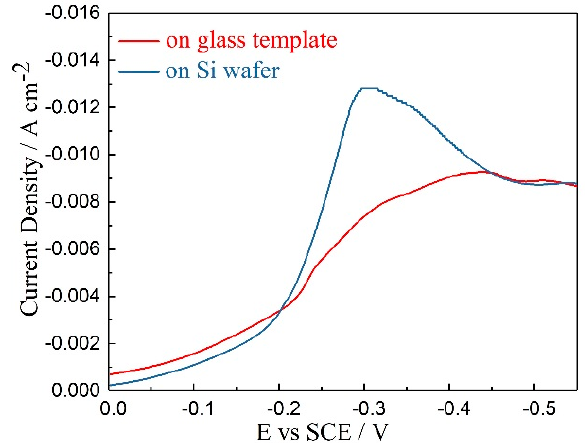
Figure 6. Cyclic voltammograms of Sb-Te electrodeposition on the Si wafer-based Pt electrode and glass template at room temperature at a scan rate of 5 mV/s with an electrolyte containing 8 mM of SbO + and 12 mM of HTeO 2+ .